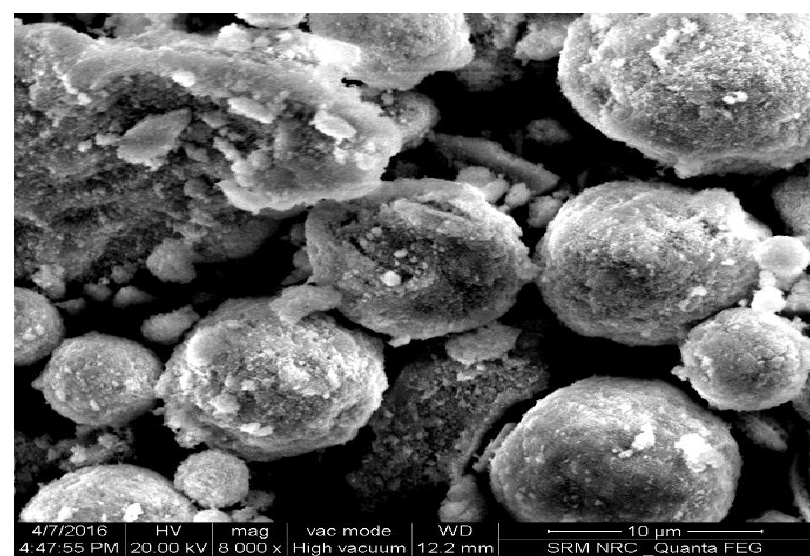
Figure 2. SEM image of the ZrO 2 (Zirconia) nanoparticles.